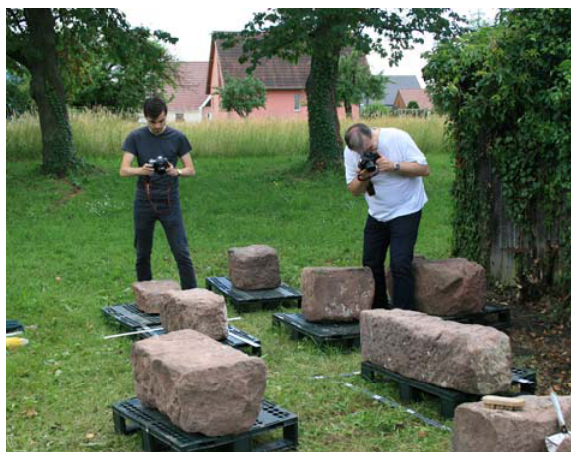
Figure 3: Photogrammetric recording in Horbourg-Wihr's block-park. Blocks stored on pallets. Use of scaling bars.